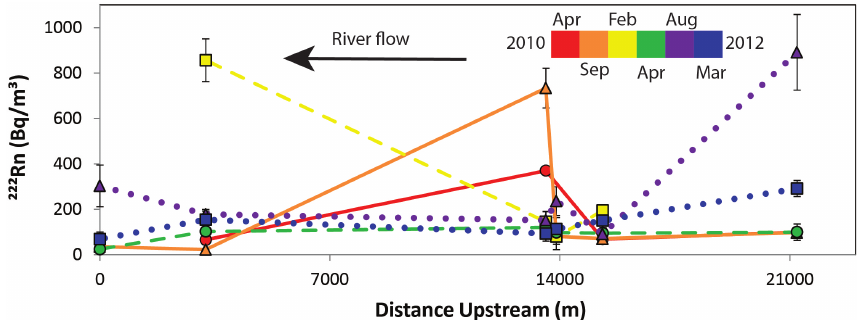
Fig. 4. Distribution of 222 Rn activities in water sampled from the Nicholson River over the study period. April 2010=solid line with circles, September 2010=solid line with triangles, February 2011=dashed line with squares, April 2011=dashed lines with circles, Au- gust 2011=dotted line with triangles, March 2012=dotted line with squares.